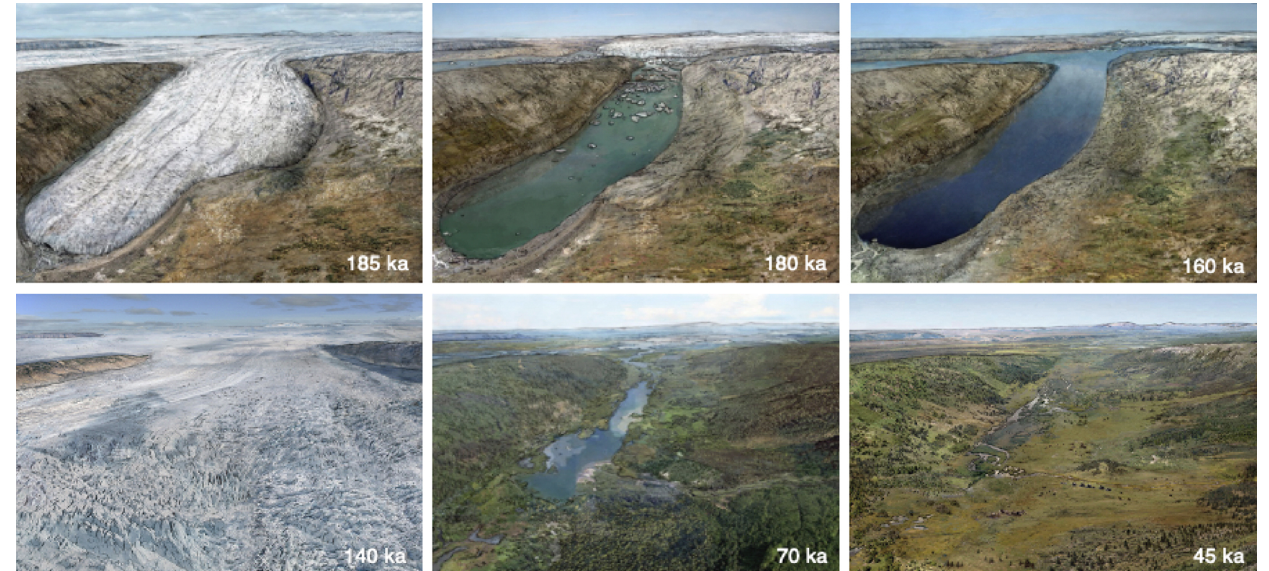
Figure 5. Landscape reconstruction with glacial advance and retreat sequences, based on drill-core analysis at Niederweningen (modified after Dehnert et al., 2012).